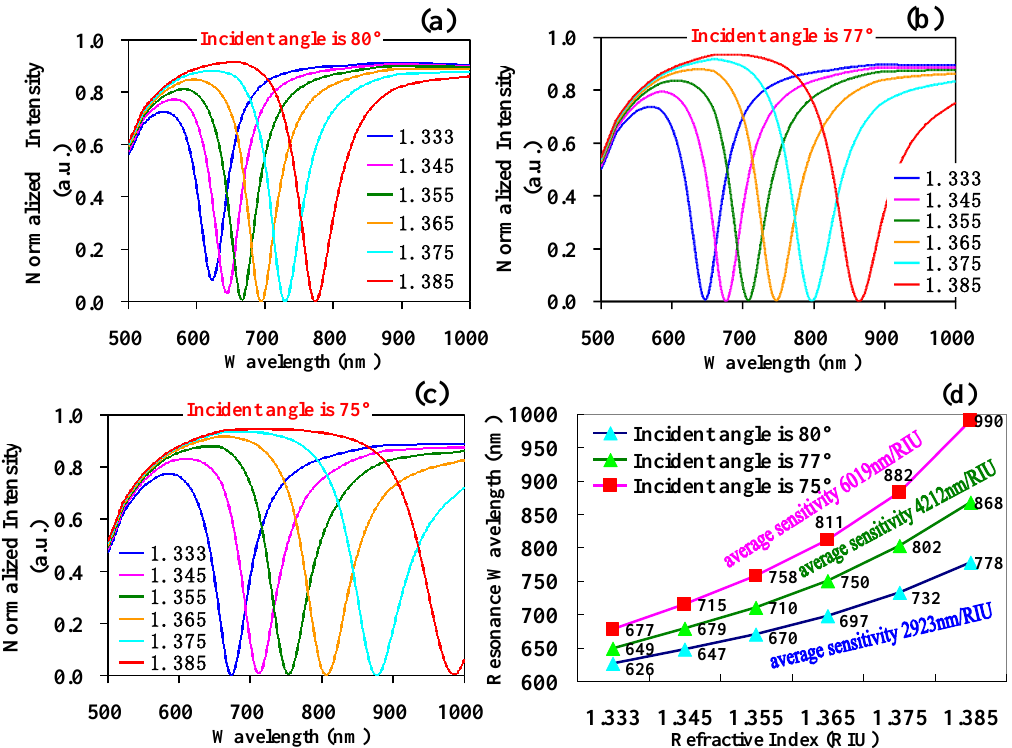
Figure 1. The simulation diagram of SPR signals with incident angles of ( a ) 80°, ( b ) 77°, and ( c ) 75°; ( d ) The corresponding resonance wavelength and average sensitivity of different incident angles under the detection range of the same refractive index.